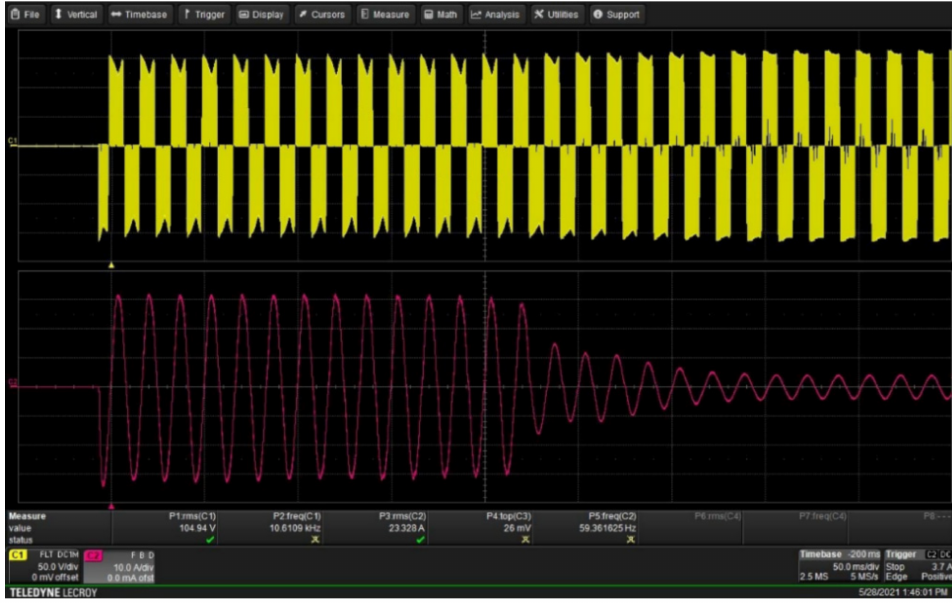
Figure 14. Experimental results of voltage and current at the output of the modular single-phase FB VSI, in dynamic state (50 V/div, 10 A/div, 50 ms/div).